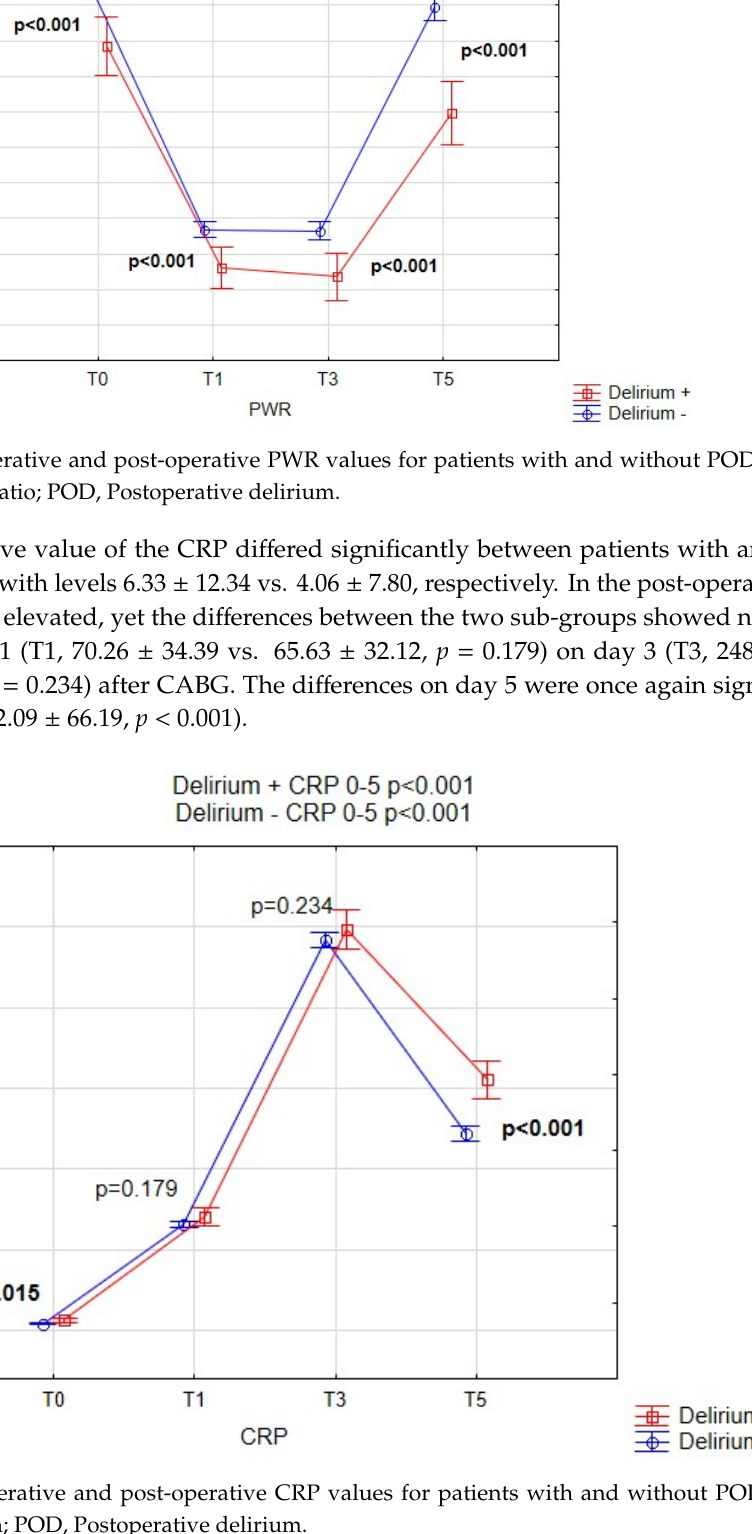
Figure 3. Pre-operative and post-operative PLR values for patients with and without POD. PLR, platelet-to-lymphocyte ratio; POD, Postoperative delirium.